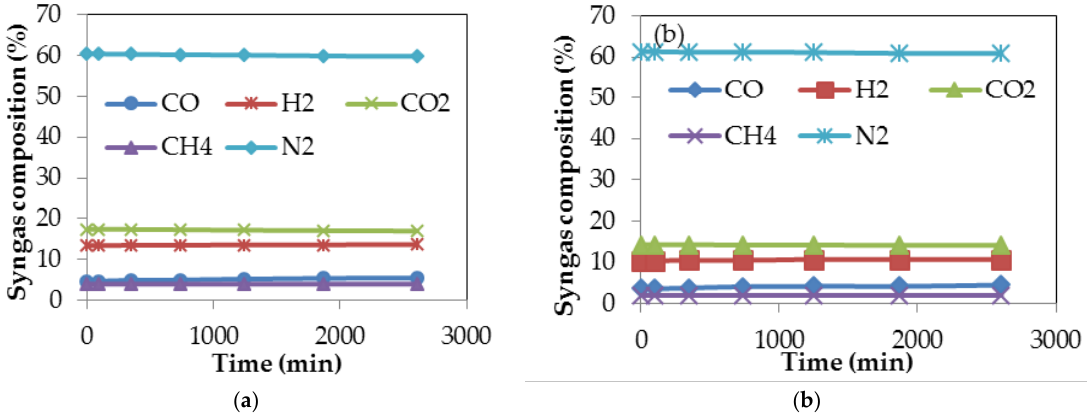
Figure 7. Syngas composition obtained after computer simulation of the gasification processes of ( a ) torrefied SCB; and ( b ) untorrefied SCB.